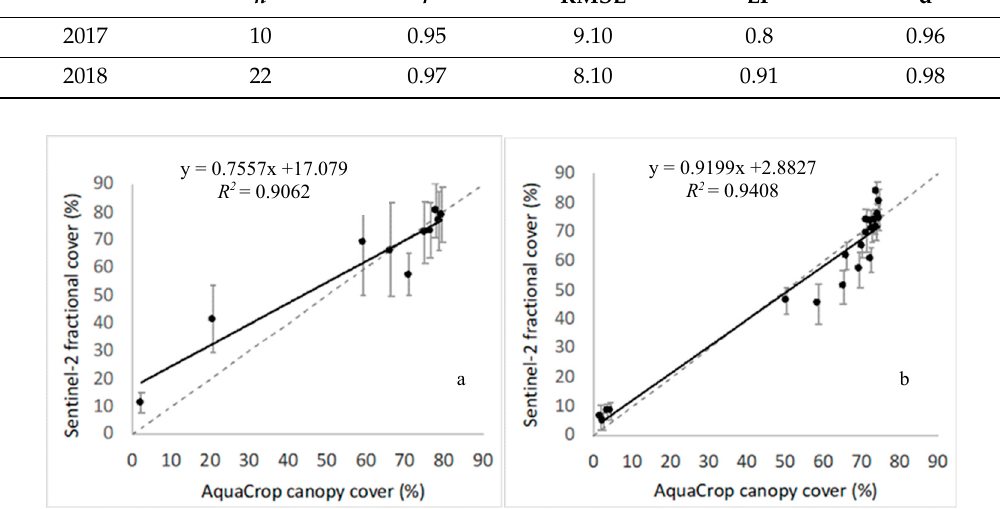
Figure 4. Canopy cover of tomato simulated by AquaCrop, after calibration with field data (line) and corresponding fractional cover values (dots) retrieved by Sentinel-2 imagery during 2017 ( a ) and 2018 ( b ) growing seasons, with corresponding standard deviations. Table 4. Evaluation of canopy cover simulation results: Number of observations / simulations (n), Pearson correlation coe ffi cient (r), root mean square error (RMSE%), Nash–Sutcli ff e model e ffi ciency Table 4. Evaluation of canopy cover simulation results: Number of observations/simulations (n), coe ffi cient (EF) and Willmott index of agreement (d). Pearson correlation coefficient (r), root mean square error (RMSE%), Nash–Sutcliffe model efficiency coefficient (EF) and Willmott index of agreement (d).